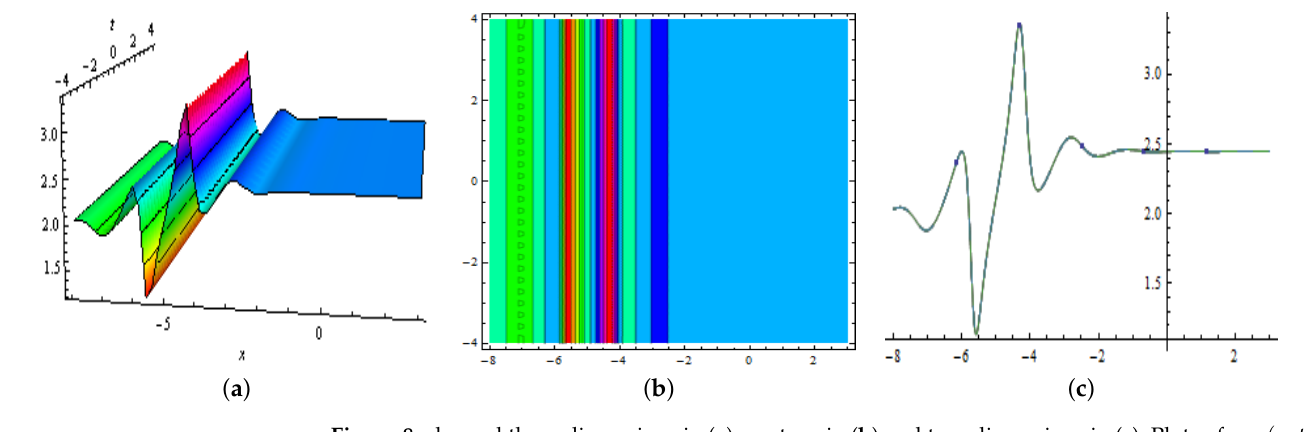
Figure 8. showed three-dimensions in ( a ); contour in ( b ) and two-dimensions in ( c ), Plots of m 39 ( x , t ) in Equation (37) for a = 1.5, b 6 = 8, b 7 = − 1, b 8 = 2, α = 0.6, respectively.